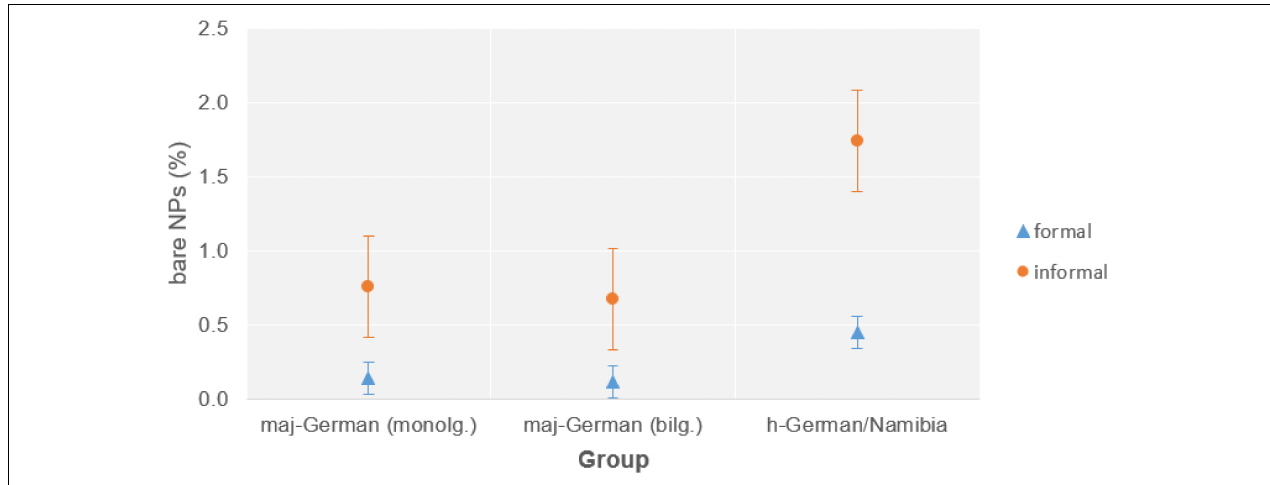
FIGURE 5 | Relative frequencies of non-canonical bare NPs (percentage of all NPs) in German in informal vs. formal settings by three different speaker groups.